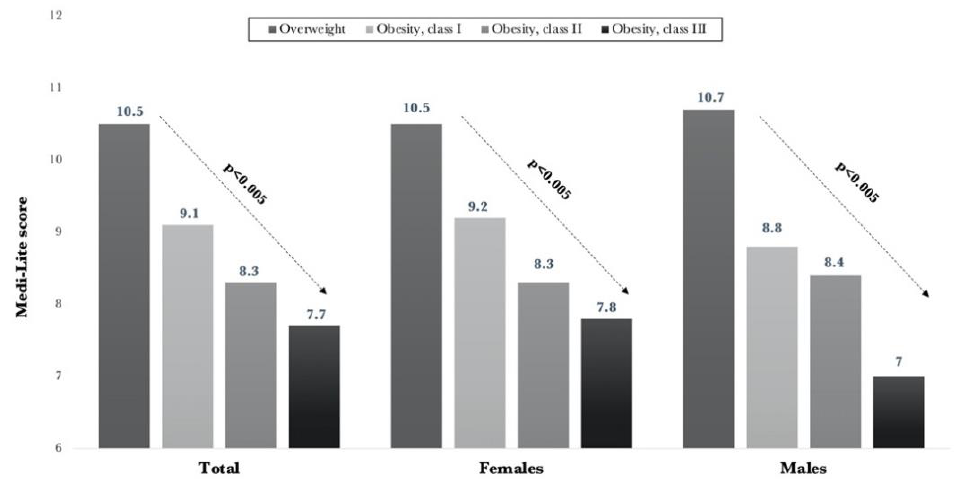
Figure 1. Medi-Lite values according to BMI categories.